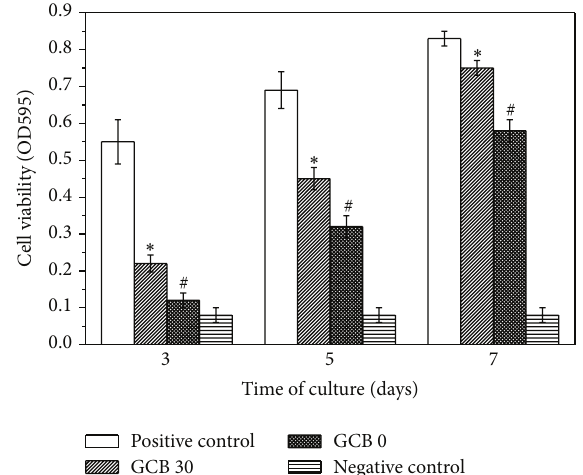
Figure 13: Cell viability after 3, 5, and 7 days of culture on composite scaffold of GCB 30 at 30/40/30 weight ratio as determined by MTT assay compared with glass substrate (positive control; paired with each material) on days 3 and 7. The control values were normalized to 100%. ∗ 𝑝 < 0.05 , # 𝑝 < 0.05 compared with the corresponding control group (mean ±